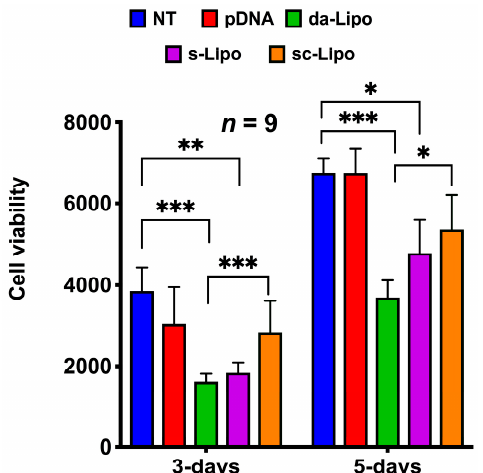
Figure 3. Cytotoxicity studies of hMSCs transfected with BMP-2 plasmid encapsulated in HA hydrogels after 3- and 5-days. The abbreviation NT = non-treated cells; pDNA = plasmid DNA alone; da-Lipo = direct addition of lipoplexes to MSC encapsulated in HA-hydrogel; s-Lipo = Lipofectamine TM 2000 assisted transfection of cells in suspension followed by encapsulation in HA-hydrogel; sc-Lipo = Lipofectamine TM 2000 assisted transfection of cells in suspension followed by centrifugation and subsequent encapsulation in HA-hydrogel. Mean values ± SD of 3 independent experiments done in triplicates ( n = 9) are shown. Statistical analysis was performed using one-way ANOVA with Bonferroni’s multiple comparison corrections (* p < 0.01, ** p < 0.001, *** p < 0.0001).